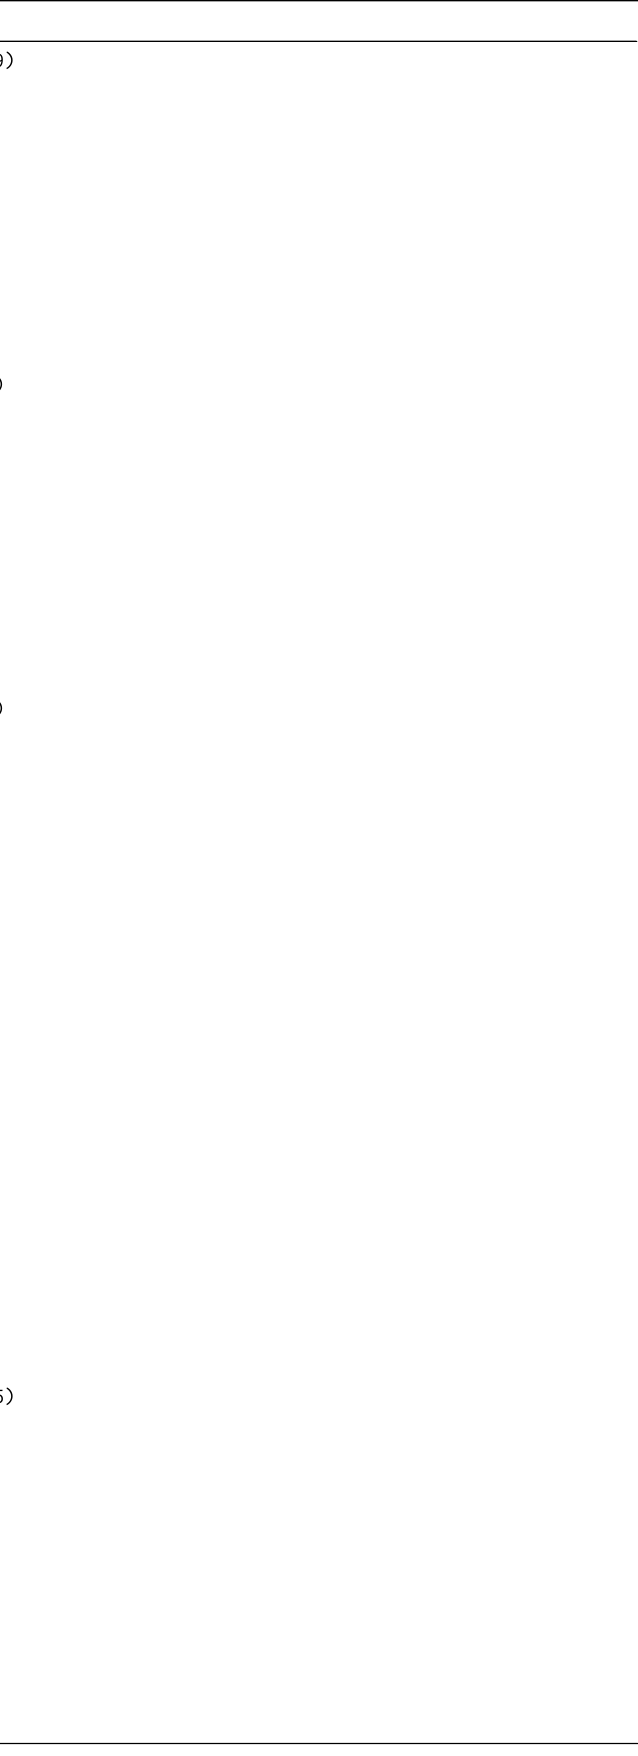
Table 3. Targeted clinical